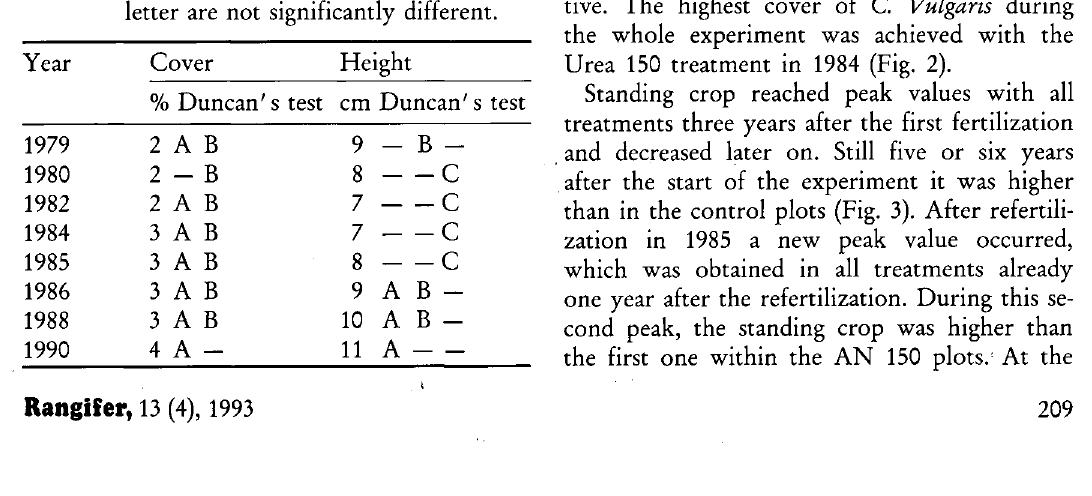
Table 5. Mean cover crop and mean height of Cla dina stellaris in the control plots and test of significant differences (Duncan's multiple range test). Years with the same letter are not significantly different.